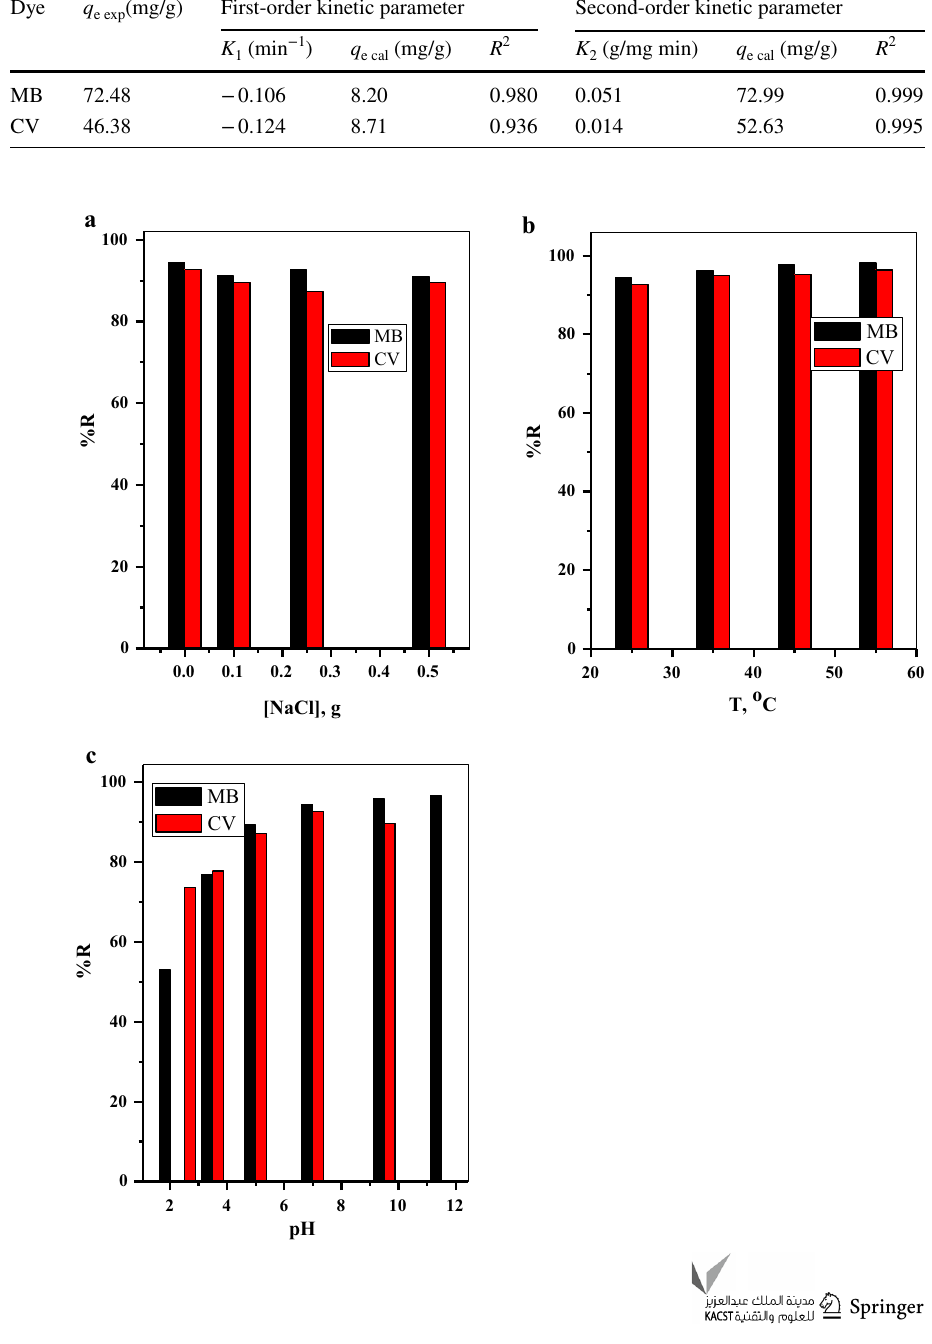
Table 2 Calculated parameters of the pseudo-first-order and pseudo-second-order kinetic models of batch